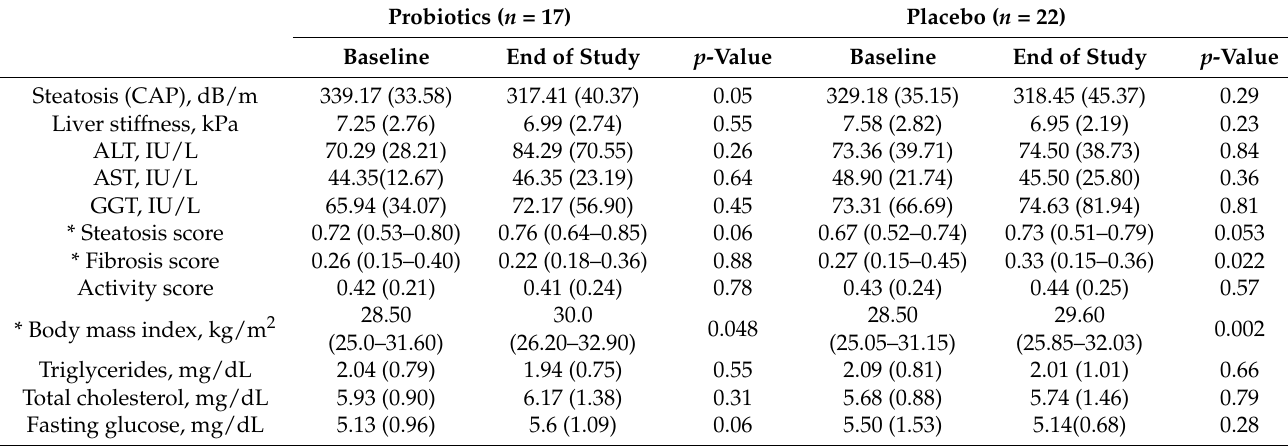
Table 3. Clinical parameters at baseline and the end of the study by intervention group.